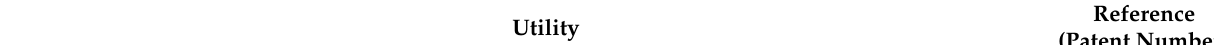
Table 2. Examples of cannabinoid-based pharmaceutical compositions have been patented for the maintenance of general oral hygiene and for specific oral and dental